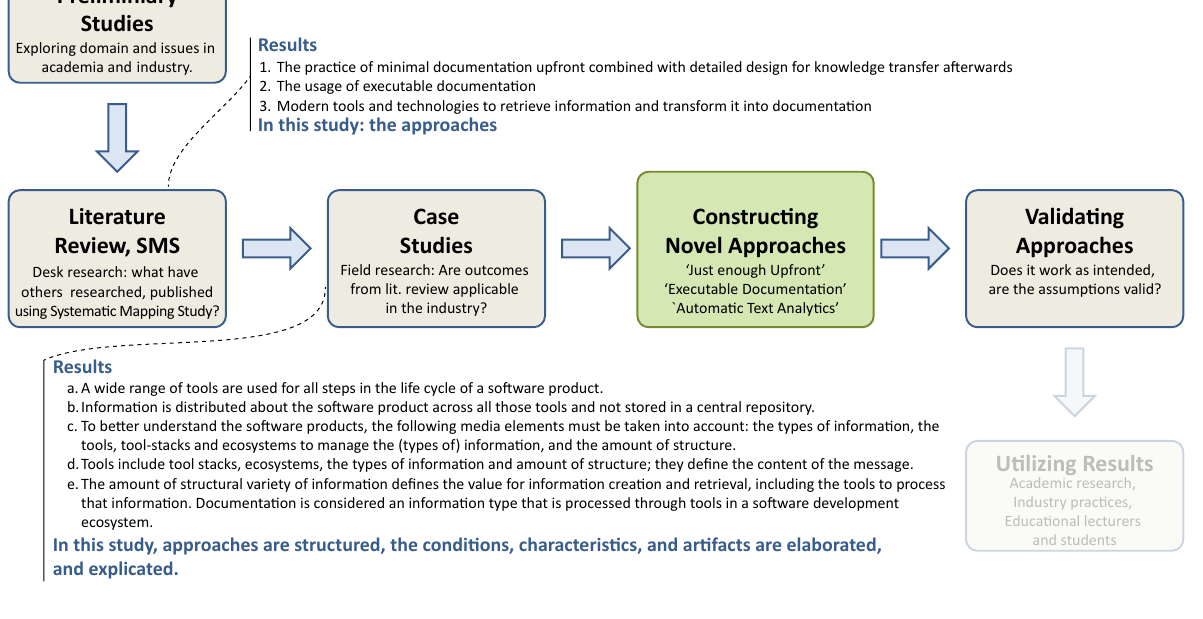
Figure 3. Studies in this research